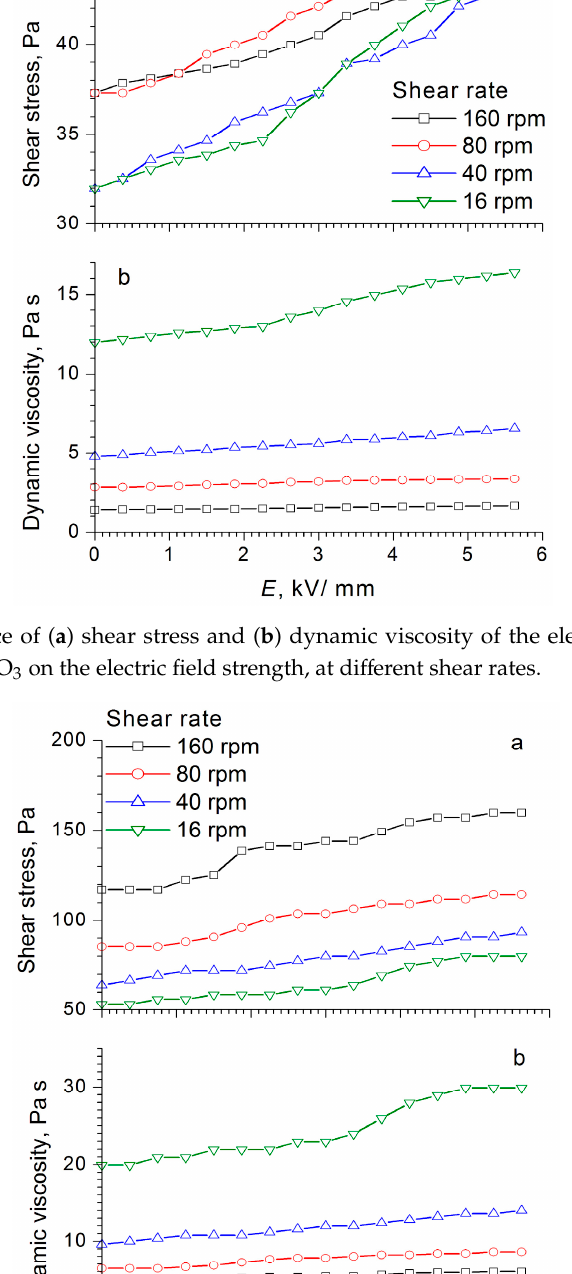
(c) Figure 7. Experimental visualization of structure formation in electrorheological fluids containing 60 wt% WO 3 /DDA, using optical microscopy. Suspensions appeared ( a ) in the absence of an electric field, ( b ) in a 1 kV/mm electric field, and ( c ) in a 1.5 kV/mm electric field. In the microphotographs, the positive electrode is at the top. During the compression of an electrorheological fluid with 60 wt% WO 3 /DDA (Figure 4) in the 1 kV/mm and 2 kV/mm electric fields, an increase of ER fluid strength was observed in comparison to the fluid with no electric field. At high values of the electric field strength, there was a regular decrease in compression stress and yield stress at compression (Figure 4). It is interesting to note that, in an electric field with 5 kV/mm strength, the strength of the ER fluid at compression was practically